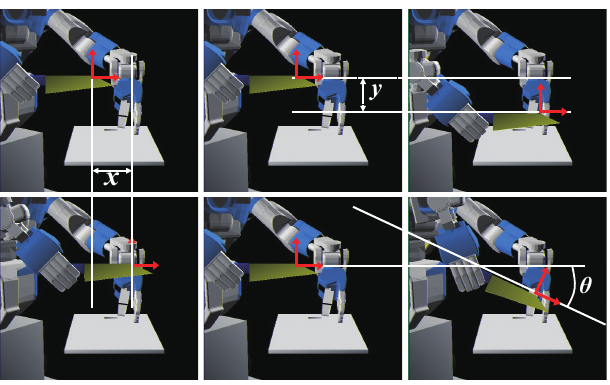
Figure 7. Parameters for cutting by knife